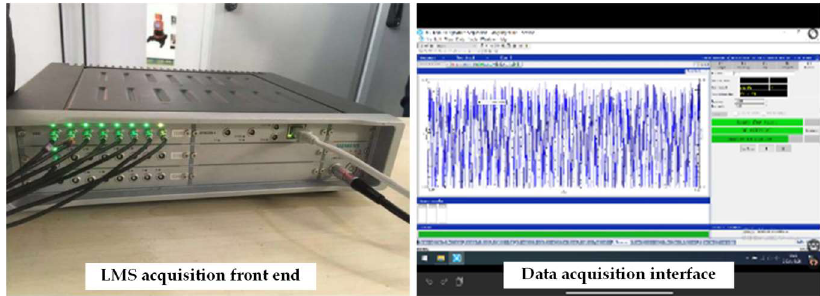
Figure 5. Arrangement of vibration sensor.